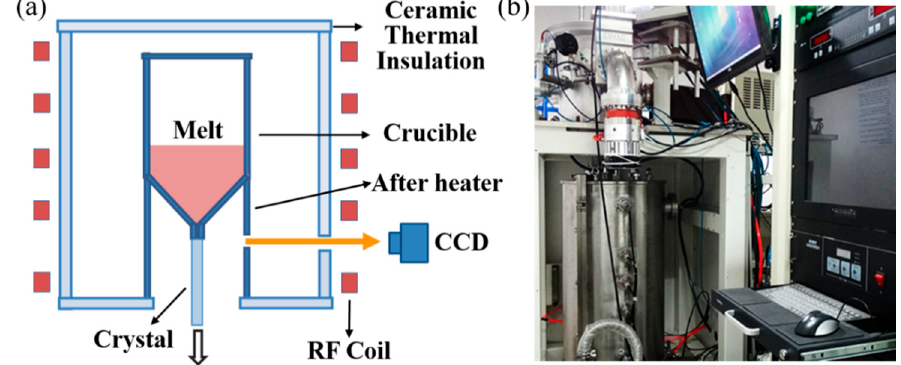
Figure 1. Schematic diagram ( a ) and equipment photo ( b ) of the micro-pulling-down ( μ -PD) technique.